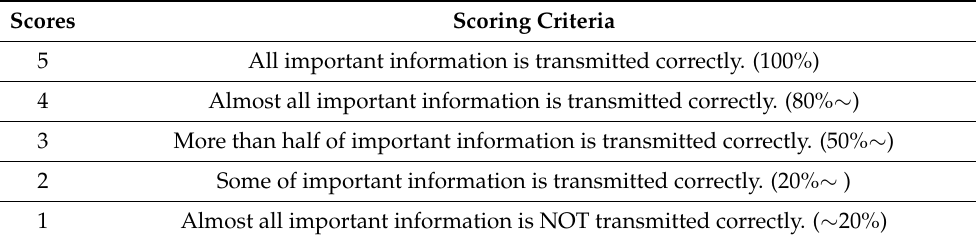
Table 3. The JPO adequacy criterion.